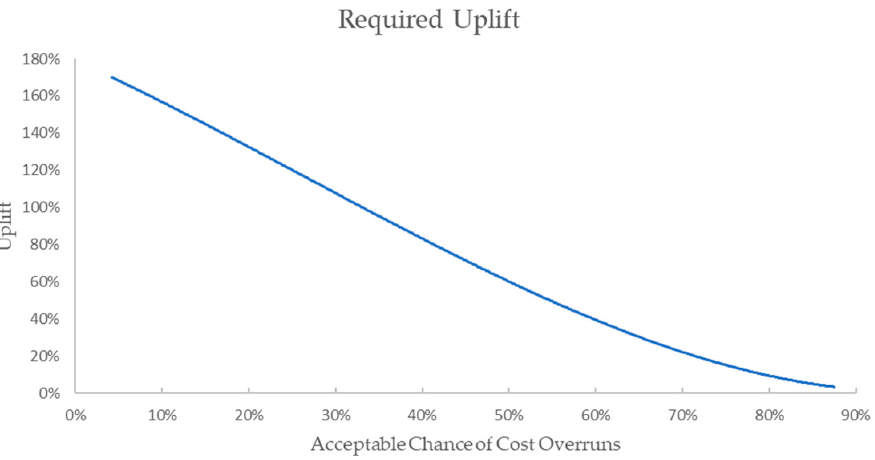
Figure 5. Required uplifts for housing projects based on acceptable chance of cost overrun.